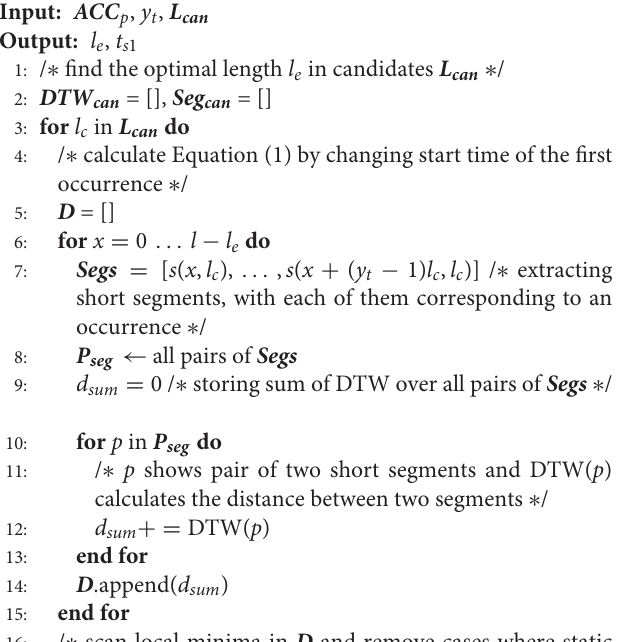
Algorithm 2 Determining the start time of the first occurrence and the length of target action.